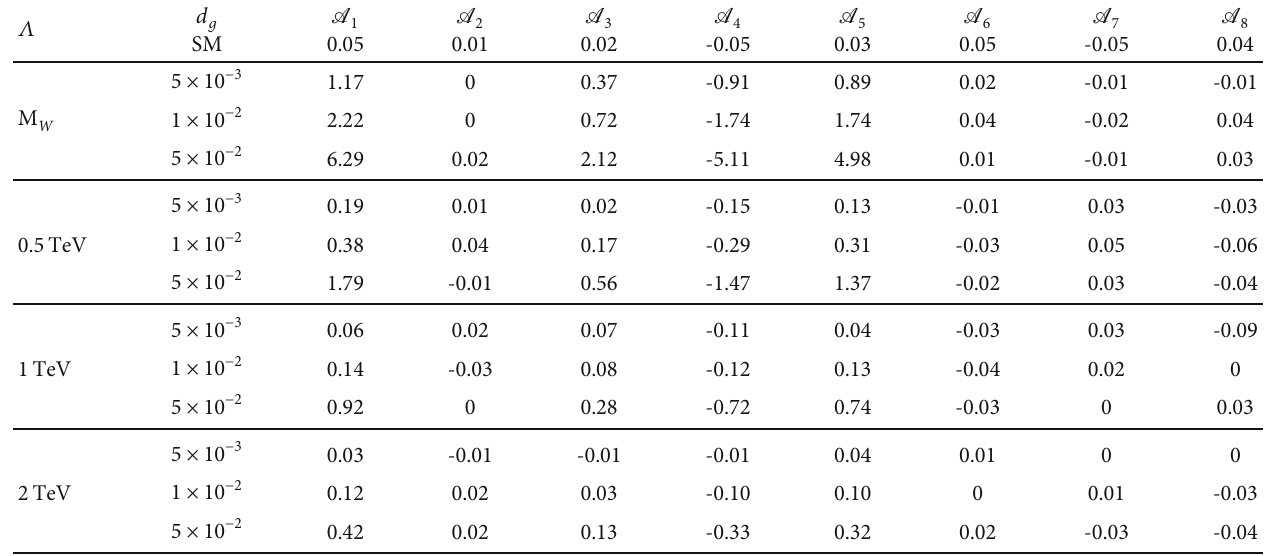
Figure 9: d vs. Λ for observable C g 3ab − 1 respectively. Table 2: Integrated asymmetries (in %) at LO for observables for distinct choices of d 3 × 10 − 4